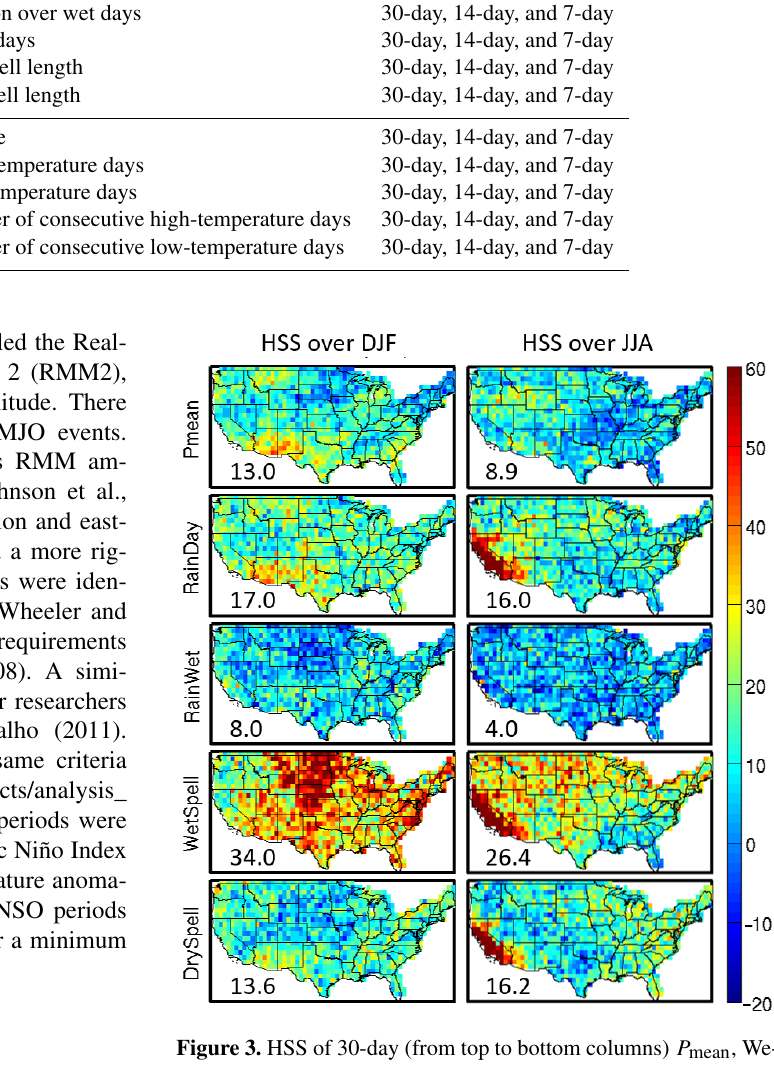
Figure 3. HSS of 30-day (from top to bottom columns) P mean , We- tRain, RainDay, WetSpell, and DrySpell from the CFSv2 daily hind- casts over DJF (left) and JJA (right). The number in the bottom left is the overall